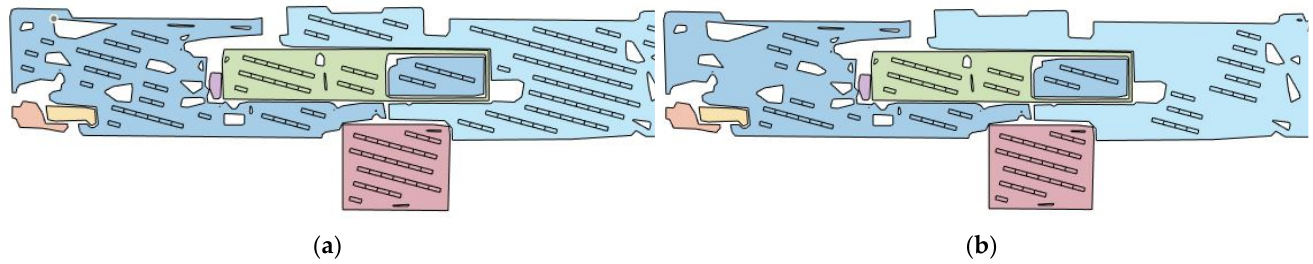
Figure 19. Comparison of PV module layout for the EAS building ( a ) without and ( b ) with shading analysis.